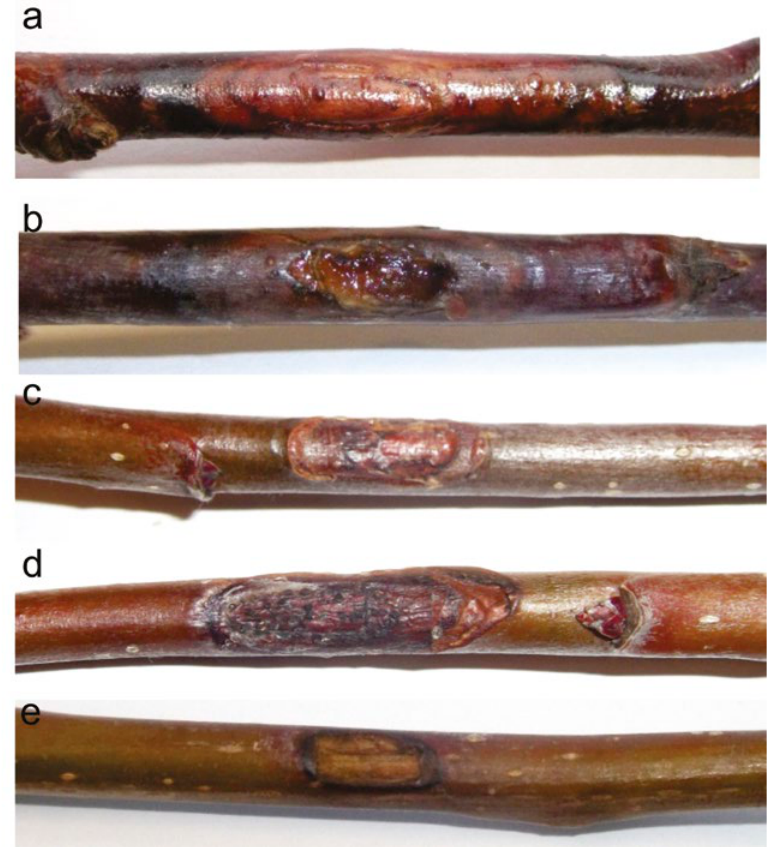
Figure 5. Symptoms observed on the cortices of branches of peach (a-b), apple (c-d) and pear (e) after the field inoculation trial. (a) reddish canker; (b) dark-brown canker with gummosis; (c) brown depressed canker cracked at the margins; (d) pycnidia on brown depressed canker cracked at the margins; (e) necrotic